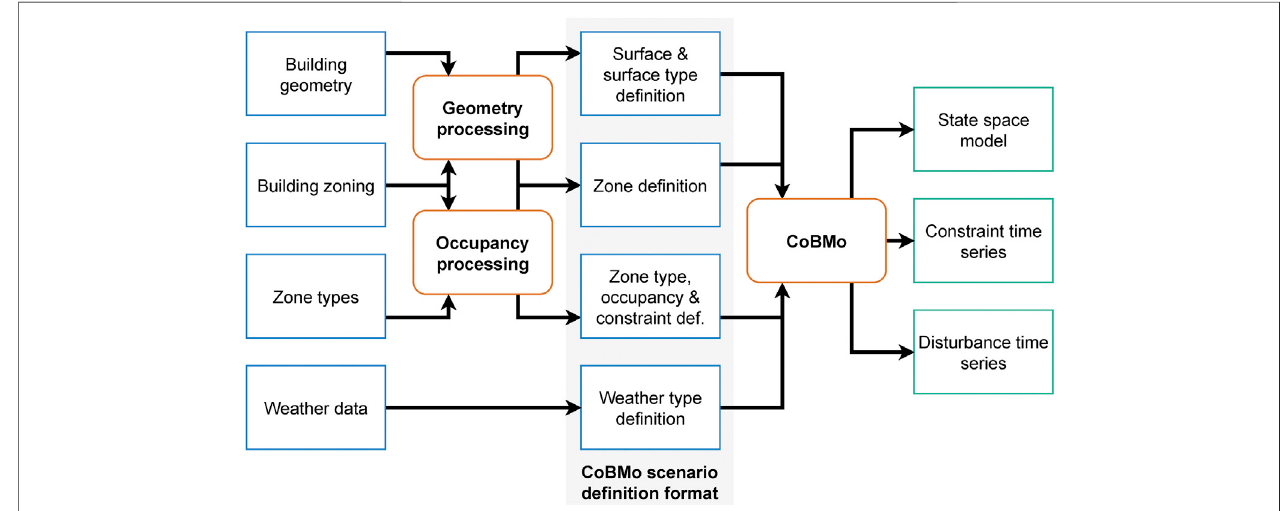
FIGURE 7 | Work fl ow for modeling the demand-side fl exibility in air-conditioned buildings.